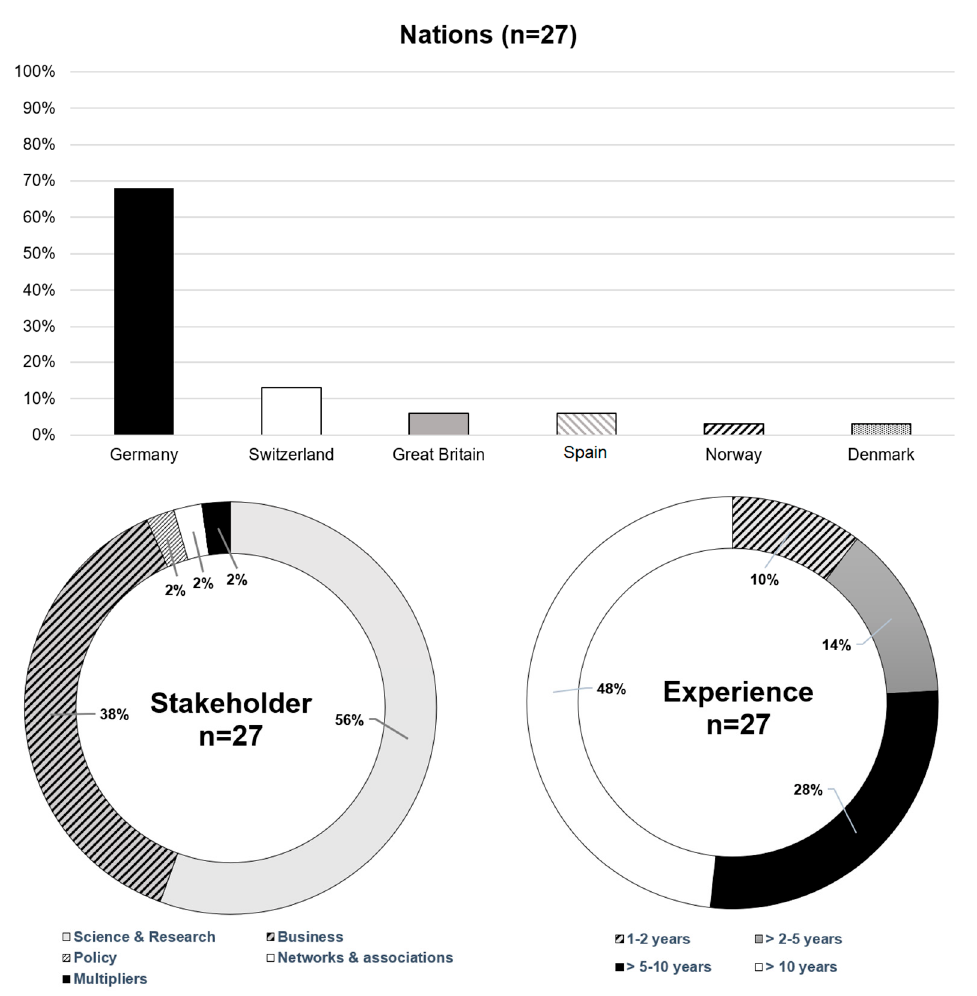
Figure 2. Participants of the first Delphi-survey round.